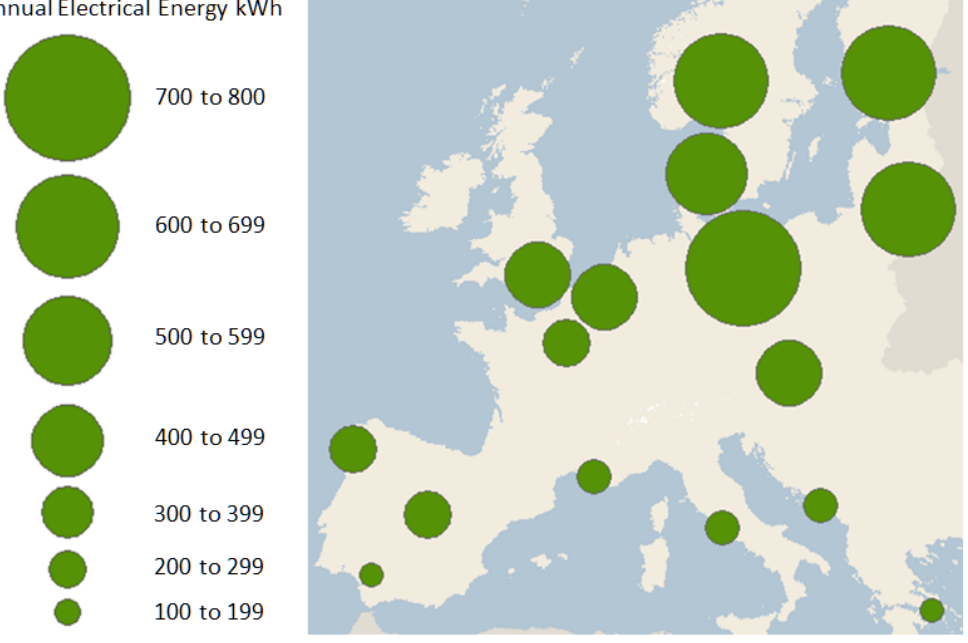
Figure 12. Simulated annual electrical energy in kWh for all of the cities in the